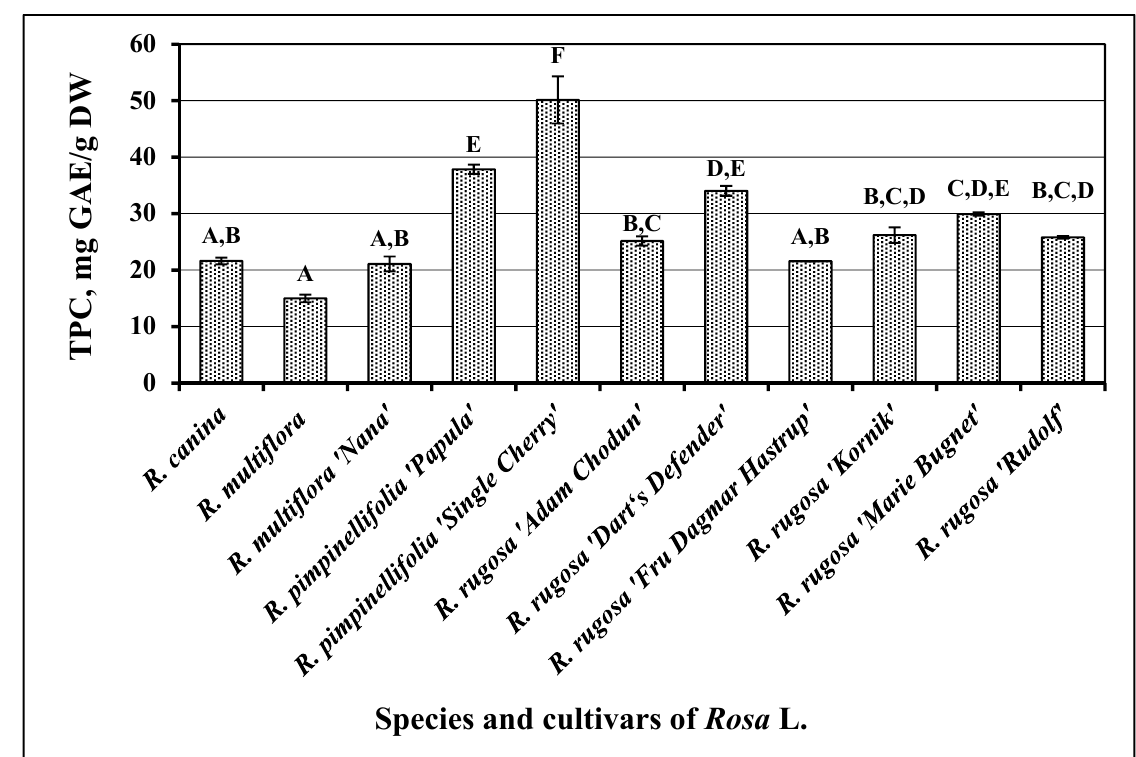
Figure 1. Variability of the total content of phenolic compounds in Rosa L. fruit samples; different letters indicate statistically significant ( p < 0.05) differences between the samples.